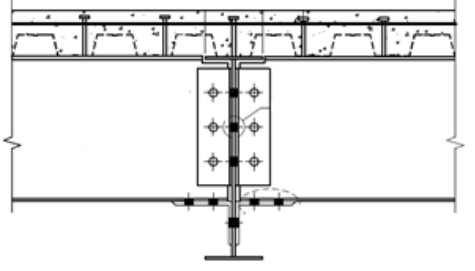
Figure 1. Composite connection (Source: adapted from ABNT NBR 8800